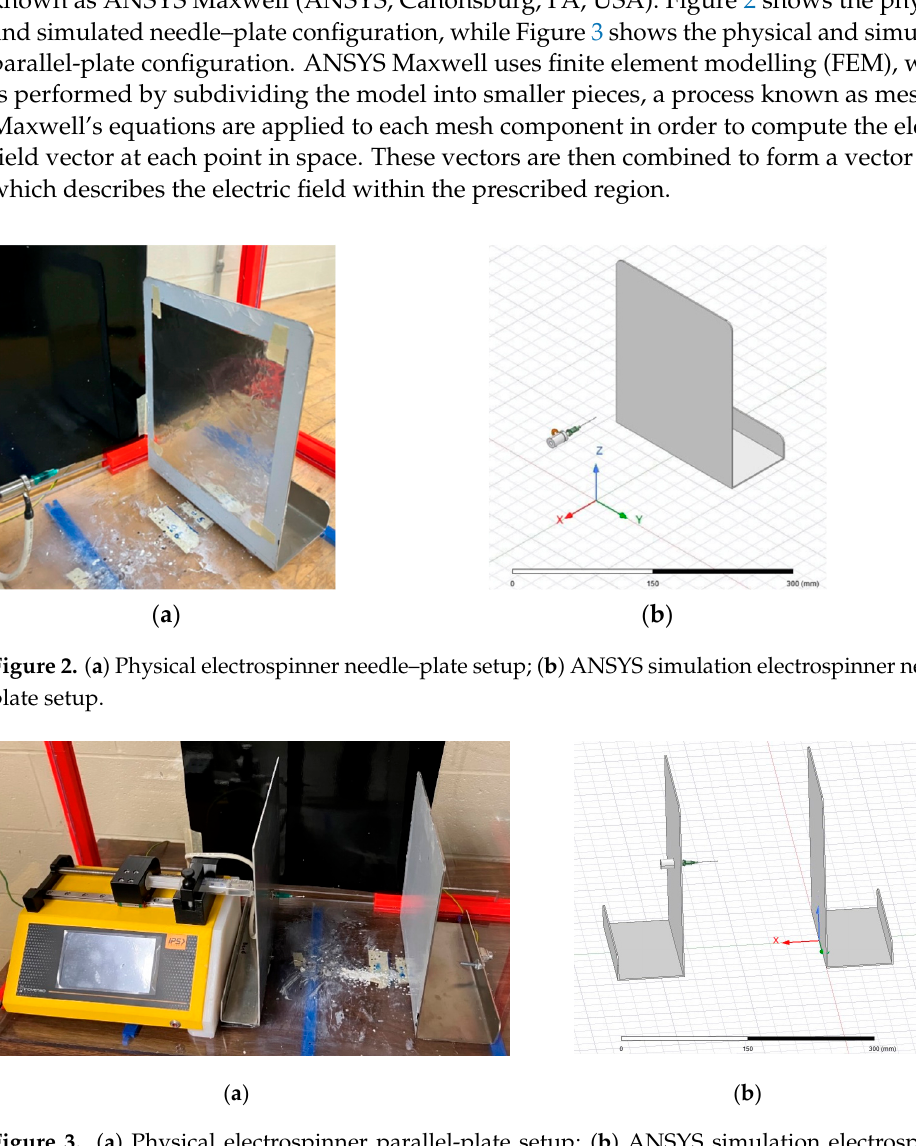
Figure 3. ( a ) Physical electrospinner parallel-plate setup; ( b ) ANSYS simulation electrospinner parallel-plate setup